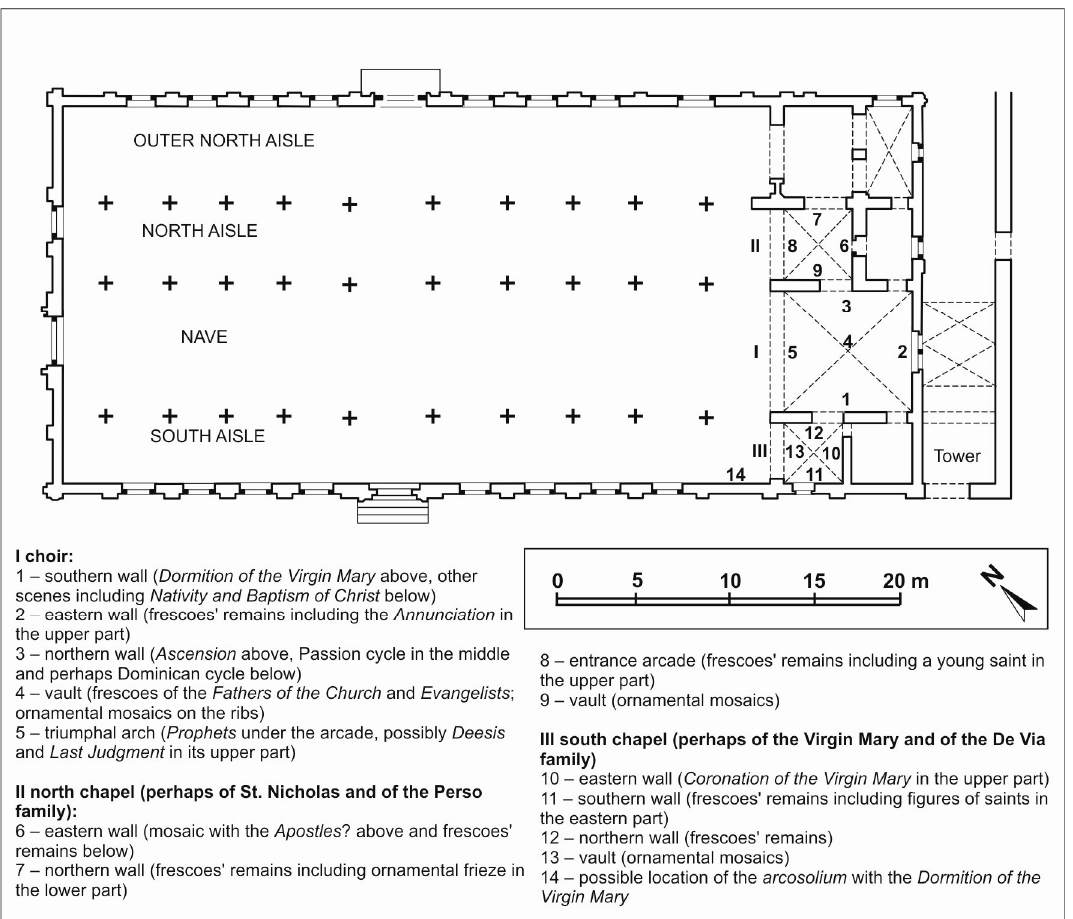
Figure 3. Pera, the church of St. Paul, present-day plan with the location of the discovered paintings, after Ivison (1996, p. 101), elaborated by Ł ukasz Quirini-Pop ł awski.